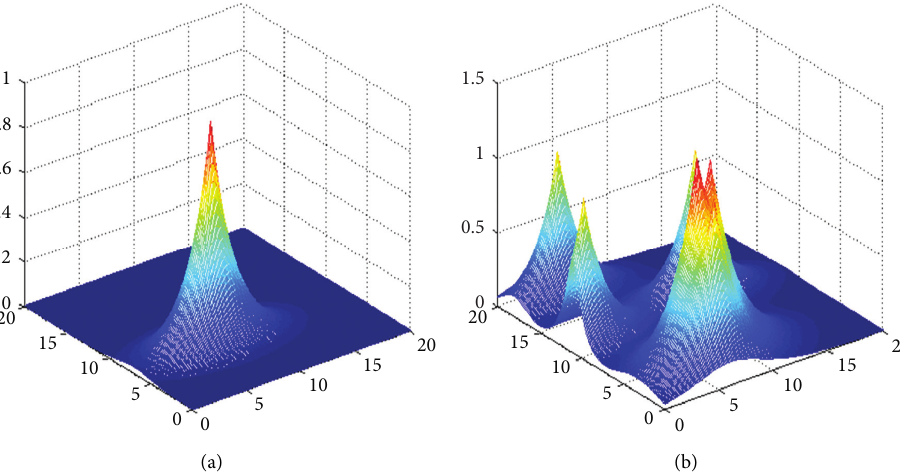
Figure 3: Field intensity distribution of sources. (a) Field intensity distribution of single source. (b) Synthetical field intensity distribution of six